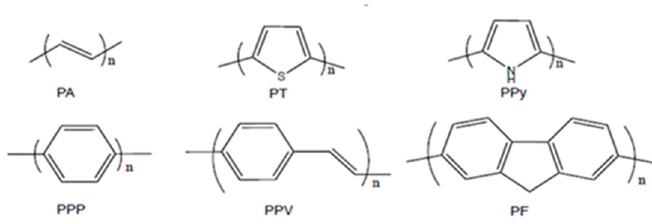
Figure 1. The structure of some of the main conjugated polymers.